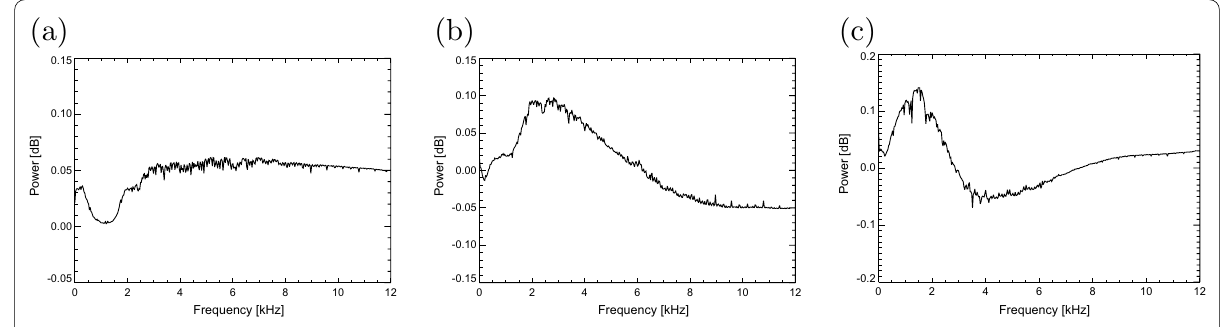
Fig. 7 First three principal component basis vectors obtained for individual frequency